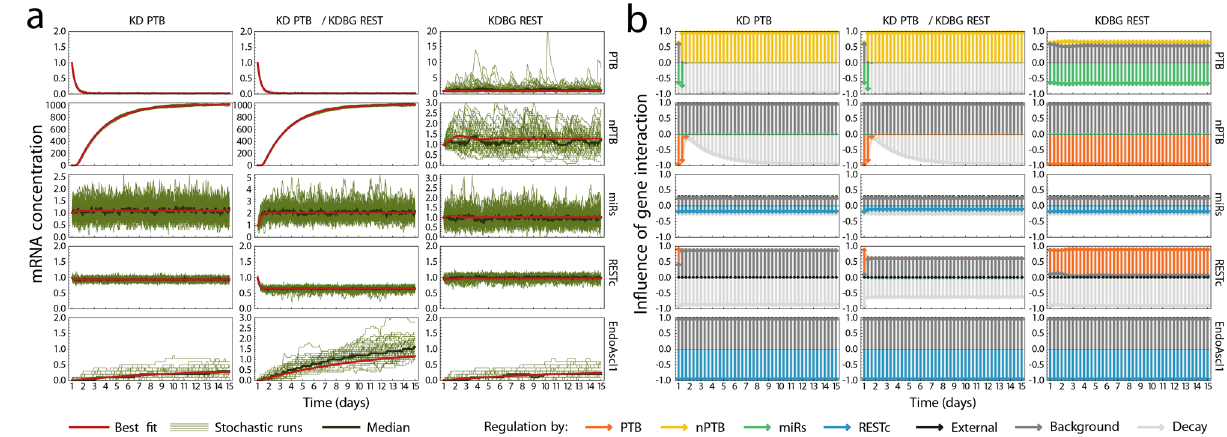
Figure 6. Strong constitutive activation of REST expression blocks neuronal reprogramming through PTB knockdown in models. ( a ) Stochastic (green) and deterministic (red) time evolution of the system. Left: simulated knockdown of PTB. The system remains in non-neural state, as seen by the lack of Ascl1 expression. Middle: combining PTB knockdown with a diminished constitutive REST activation induces Ascl1 expression. Right: with regular PTB expression, reducing constitutive REST activation results in a stable non-neuronal profile, with a steady state that strongly resembles baseline fibroblast levels. ( b ) The influence of different regulatory interactions on the expression of each factor during the deterministic experiments shown in panel ( a ) (see also Fig. 3d). See Methods for an extended description. The plots were made with Mathematica 11.3.0 (Linux version). https ://www.wolfr am.com/mathe matic